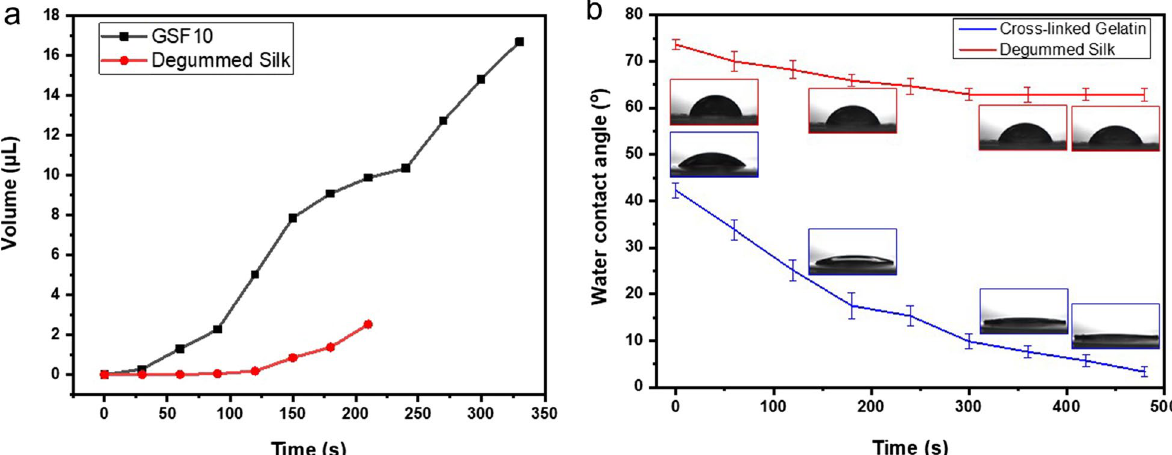
Fig. 5 a Water collection performance of GSF10 and uncoated degummed silk. b Time-dependent change of the water contact angle of gelatin and gummed